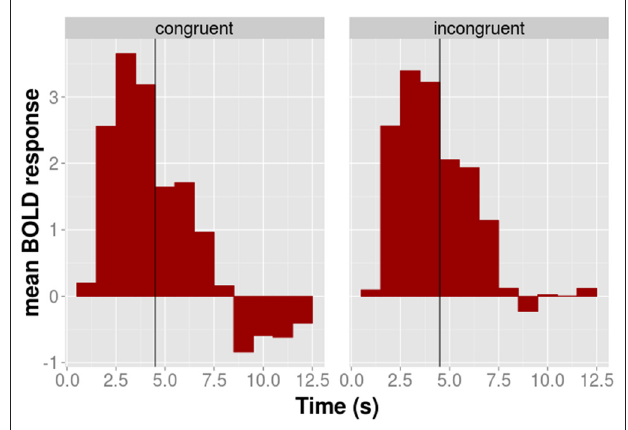
FIGURE 3 | Average BOLD activation of the 52 BA 44/45 voxels during the execution (left panel) and observation phase (right panel) shown for each of the four experimental conditions of the cross-modal session separately. The conditions are color grouped according to the type of action movement during the execution phase. Bars indicated one standard error from the mean.